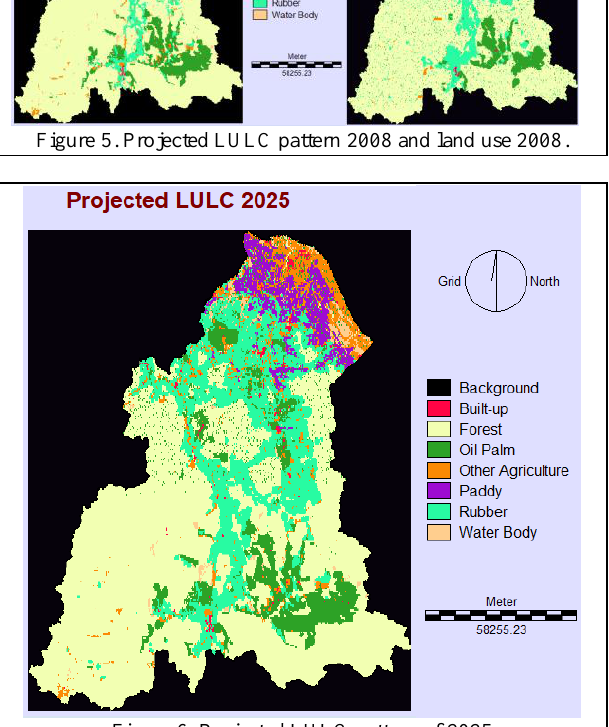
Figure 6. Projected LULC pattern of